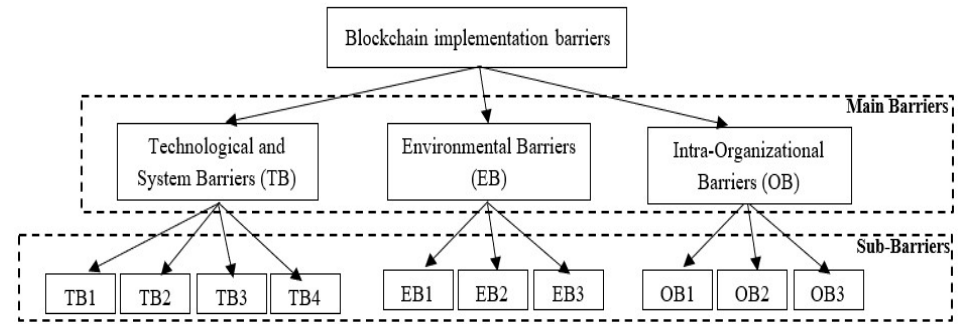
Figure 2. The hierarchical analysis model of the problem.